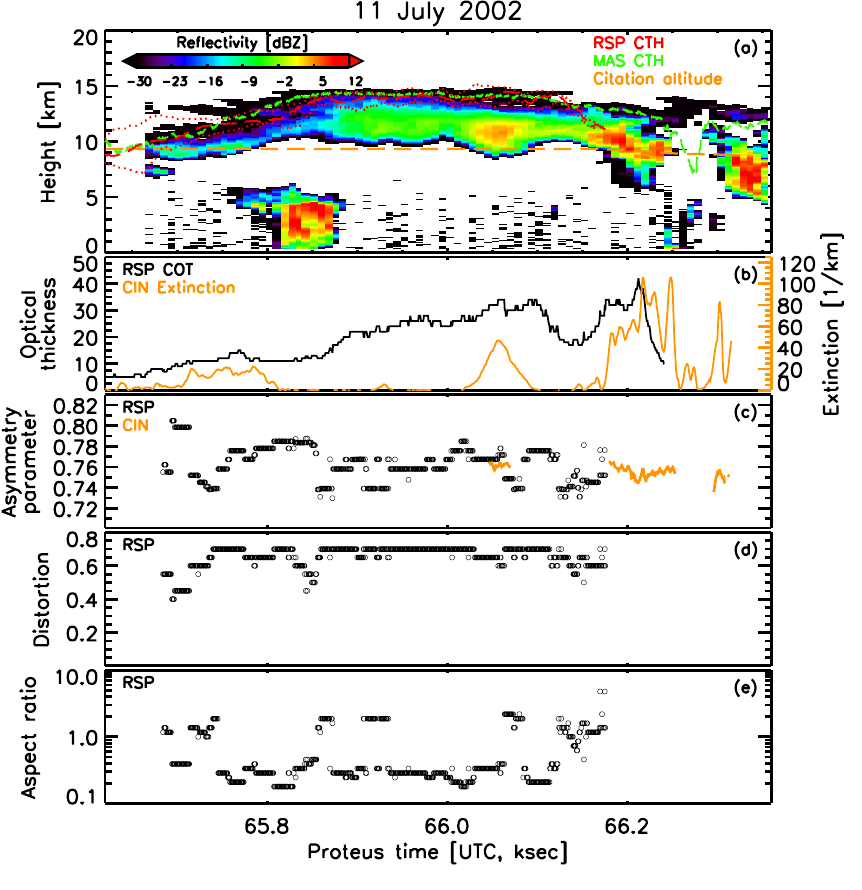
Fig. 8. Same as Fig. 3 but for 11